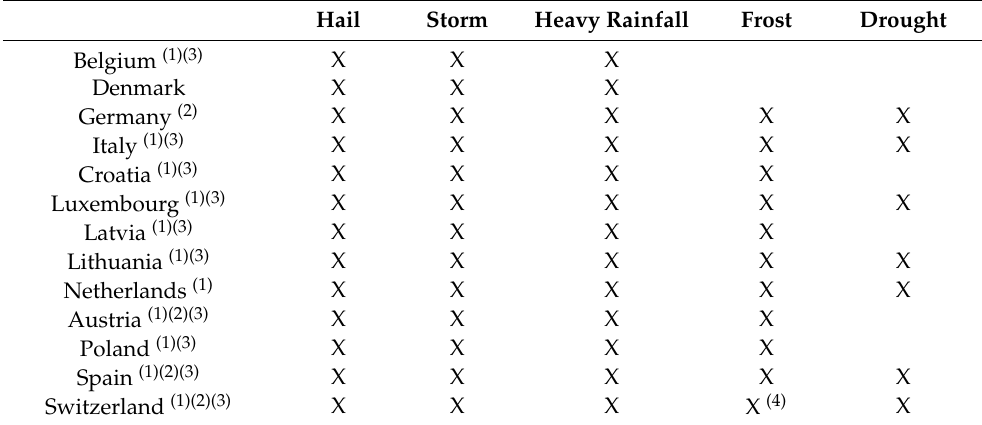
Table 1. Insurance and compensation systems in the EU-27 and Switzerland. Hail Storm Heavy Rainfall Frost